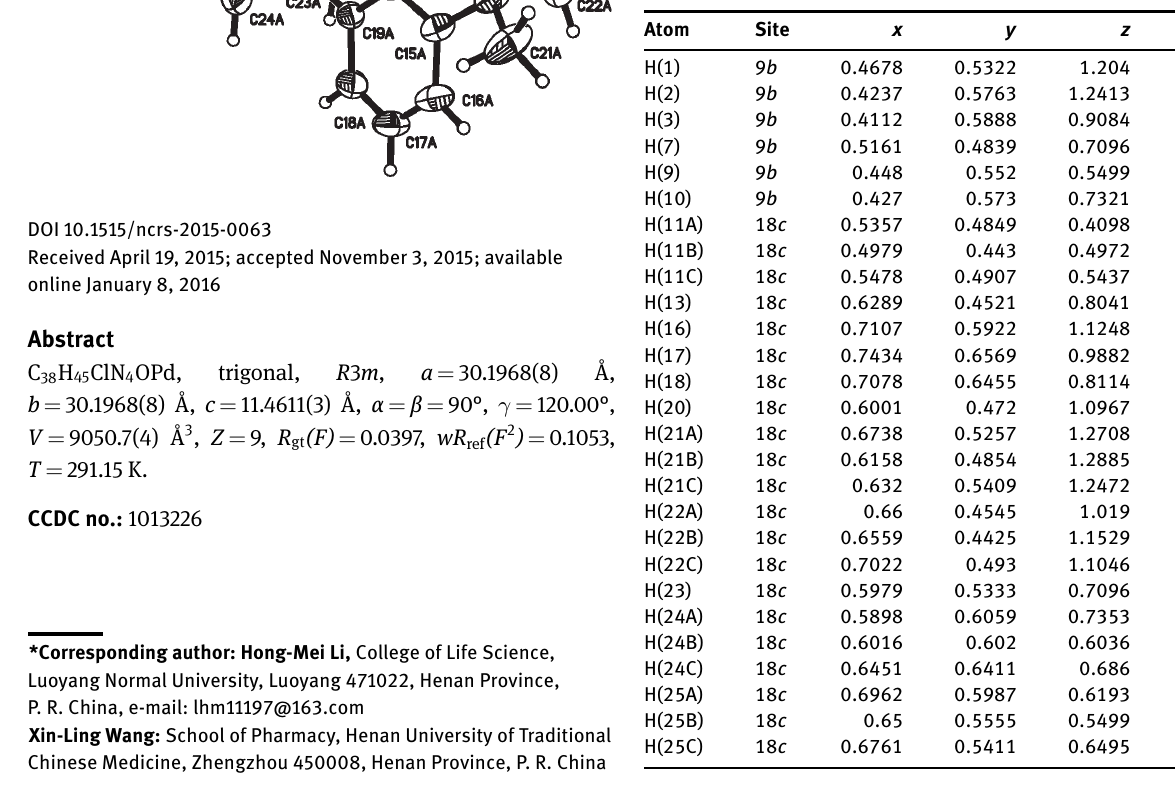
Table 2: Fractional atomic coordinates and isotropic or equivalent isotropic displacement parameters (Å 2